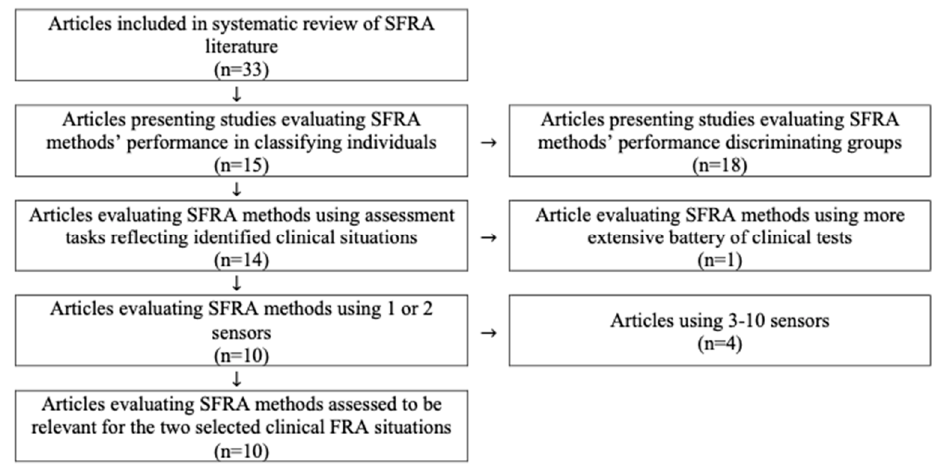
Figure 3. Flow diagram of articles analyzed for relevance for the selected clinical FRA situations from sub-study 1.